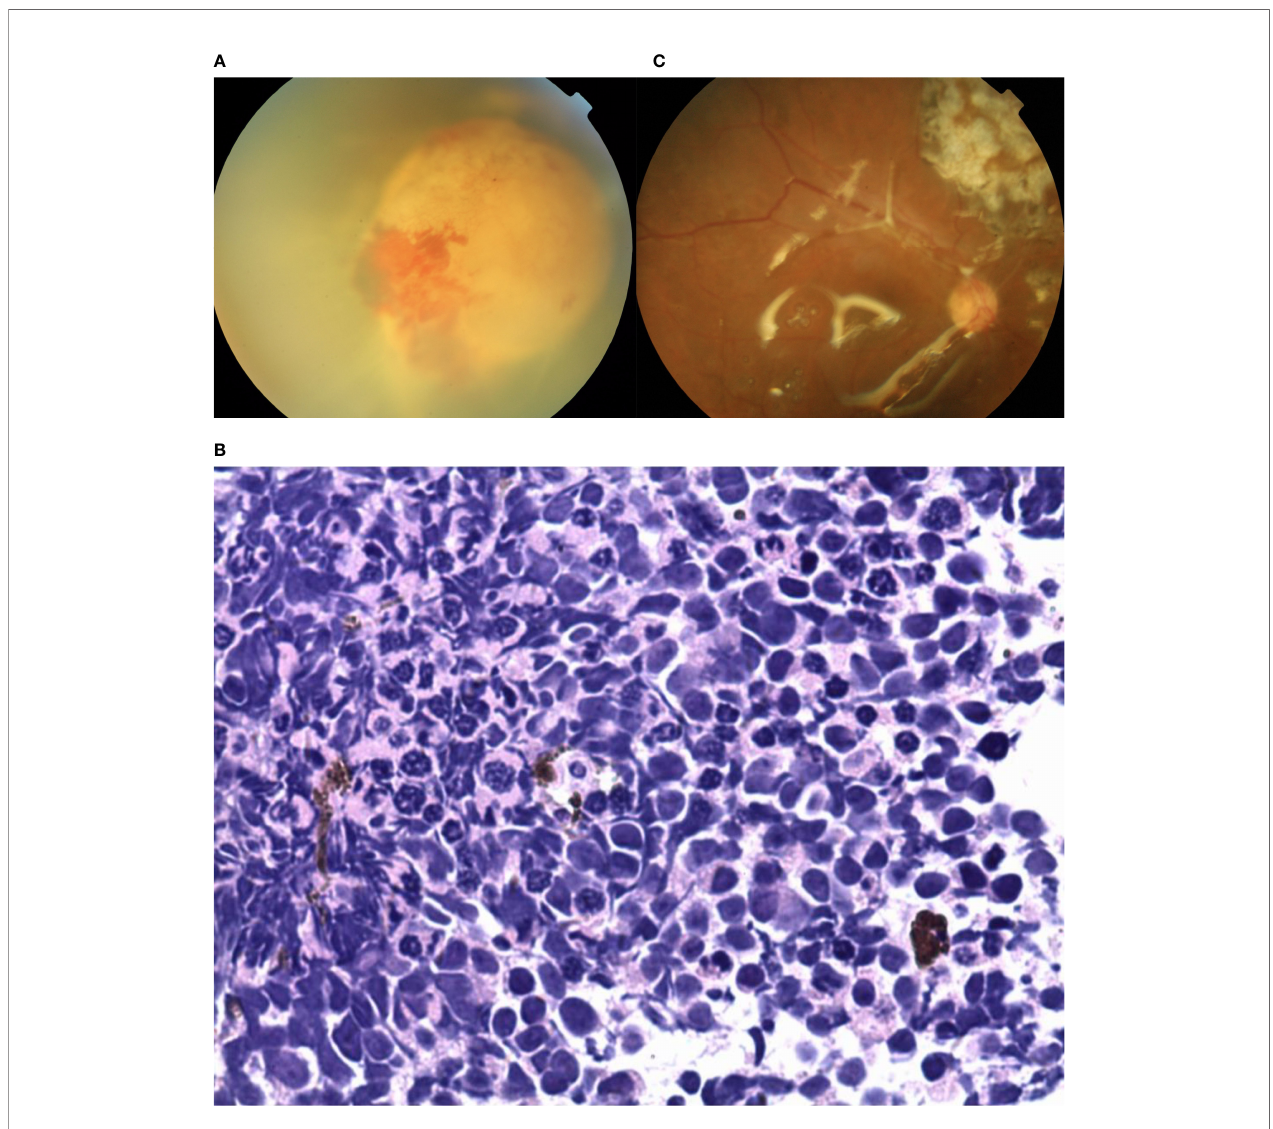
FIGURE 5 | (A) In patient 5, there was a white, circumscribed lesion of the retina located in the superotemporal peripheral fundus, with retinal exudation and subretinal fl uid in the left fundus. The feeding retinal arteriole and venule of the tumor were minimally dilated and convoluted. There was a mild, focal retinal hemorrhage on the nasal aspect of the lesion with no vitreous seeds. (B) Photomicrograph revealed the foci of Flexner-Wintersteiner rosettes. (C) In the last follow- up, the retina was well-attached and there was slight proliferation in the defect area of the